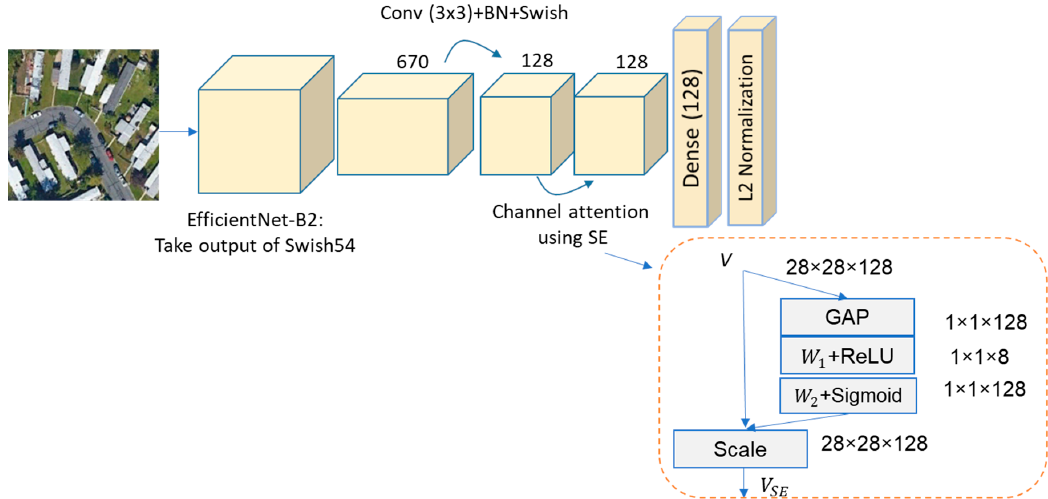
Figure 2. Image encoding branch for extracting the visual features.